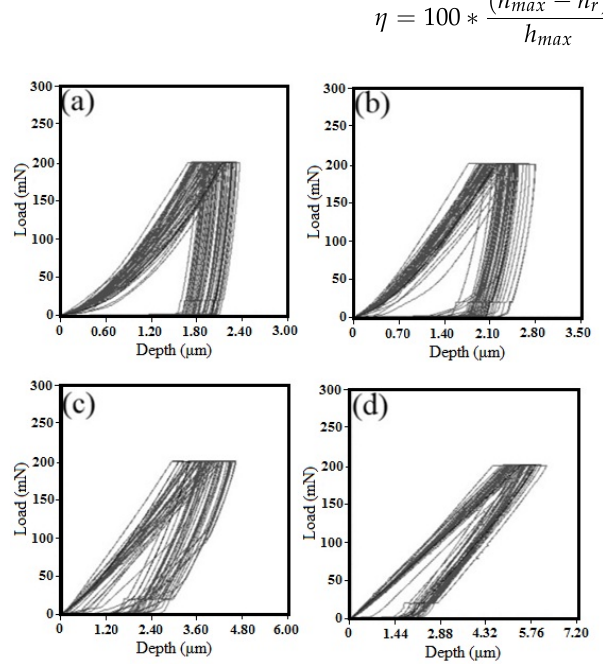
Figure 5. Penetration curves of the indenter at the measurement of ( a ) Ti substrate; ( b ) Ti-Ta coating after the first cycle; ( c ) Ti-Ta coating after the second cycle; and ( d ) Ti-Ta coating after the third cycle. Here, h max is the maximum penetration depth of the indenter and h r corresponds